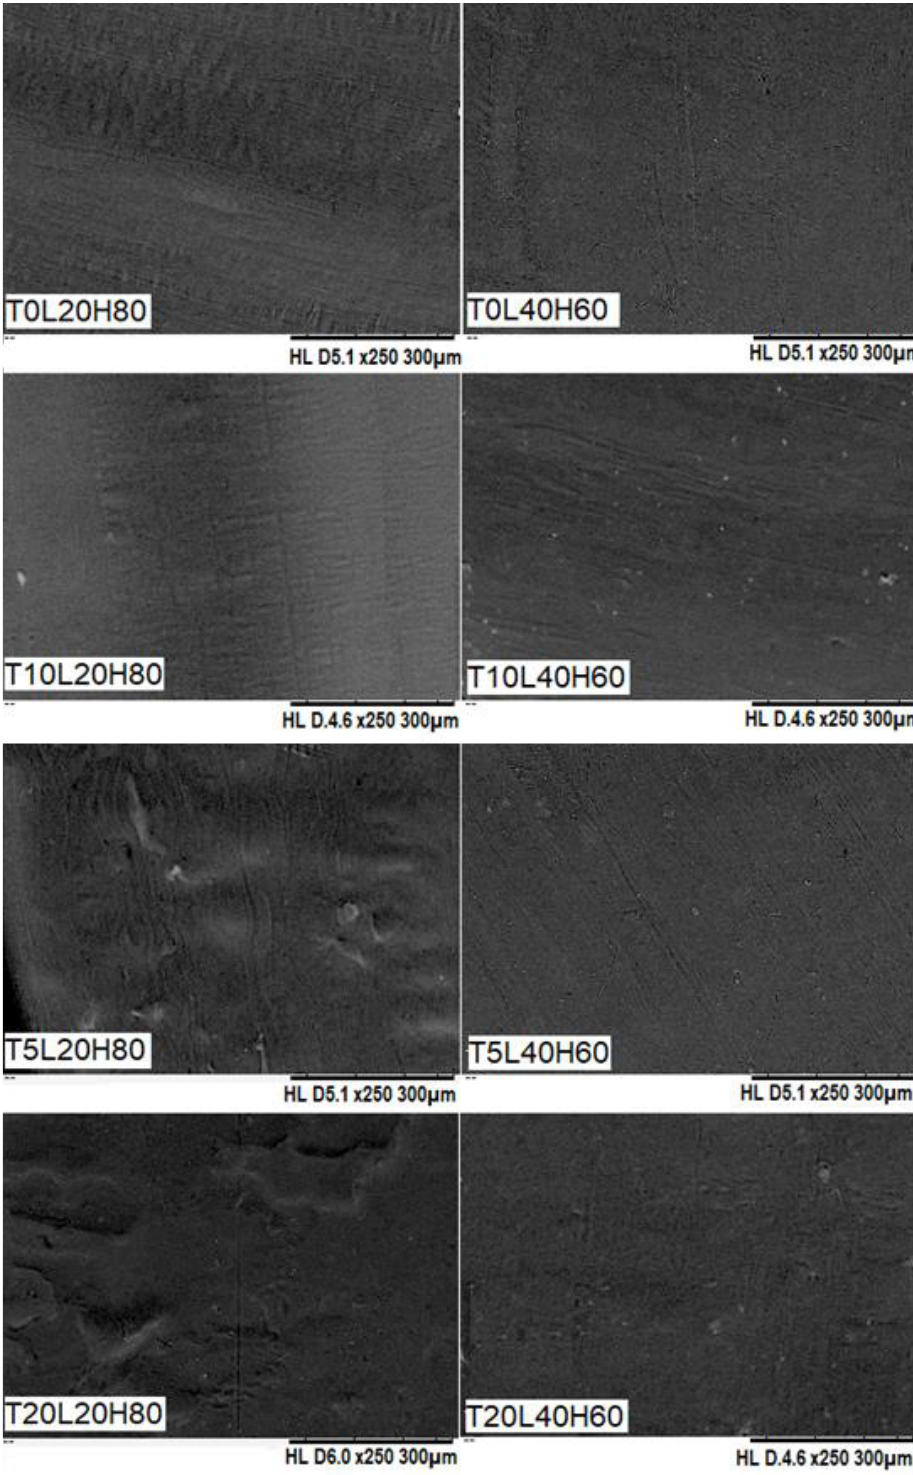
Figure 3. SEM images of blank PCL implants and TA-loaded PCL implants.